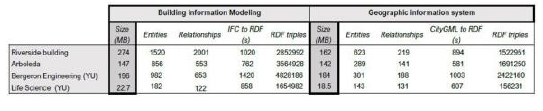
Table 2: Testing models